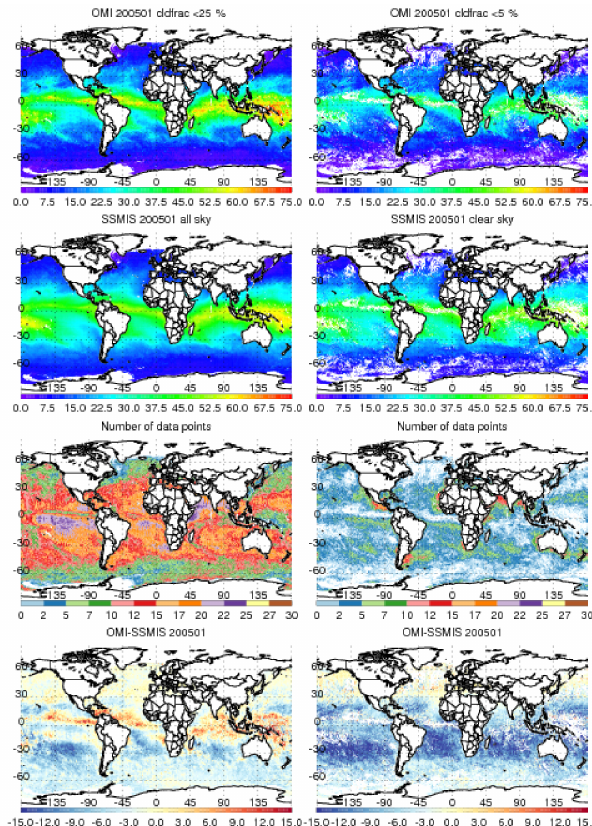
Figure 9. The same as Fig. 8 but for January